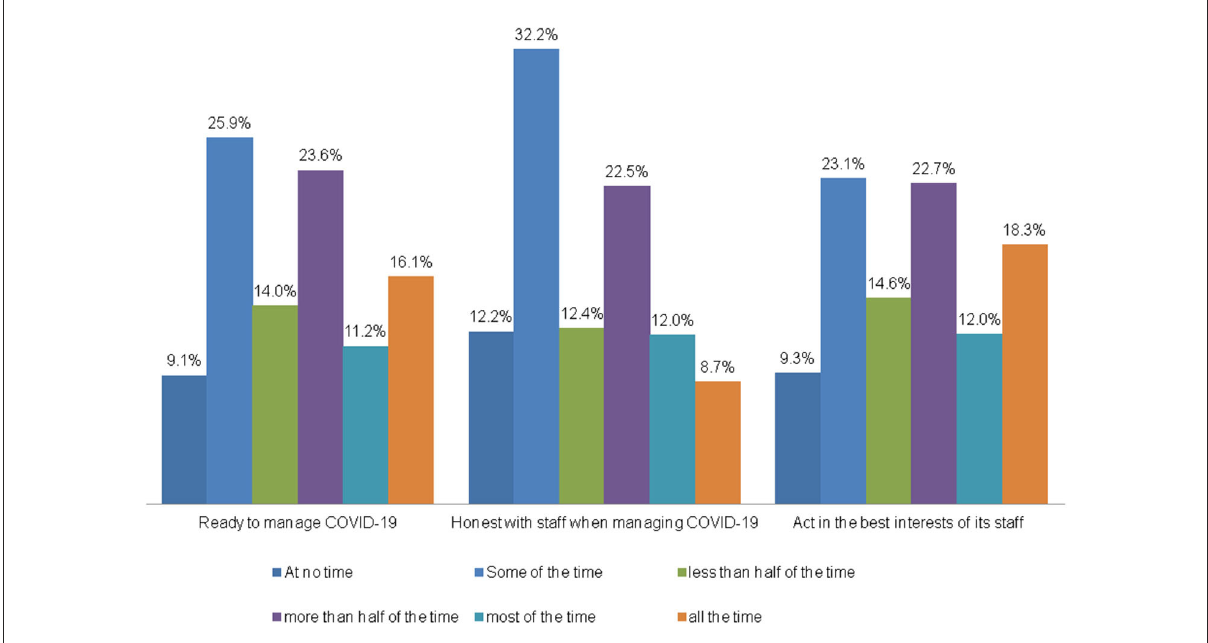
FIGURE2 HCWs’ trust in the health care facility while managing COVID-19